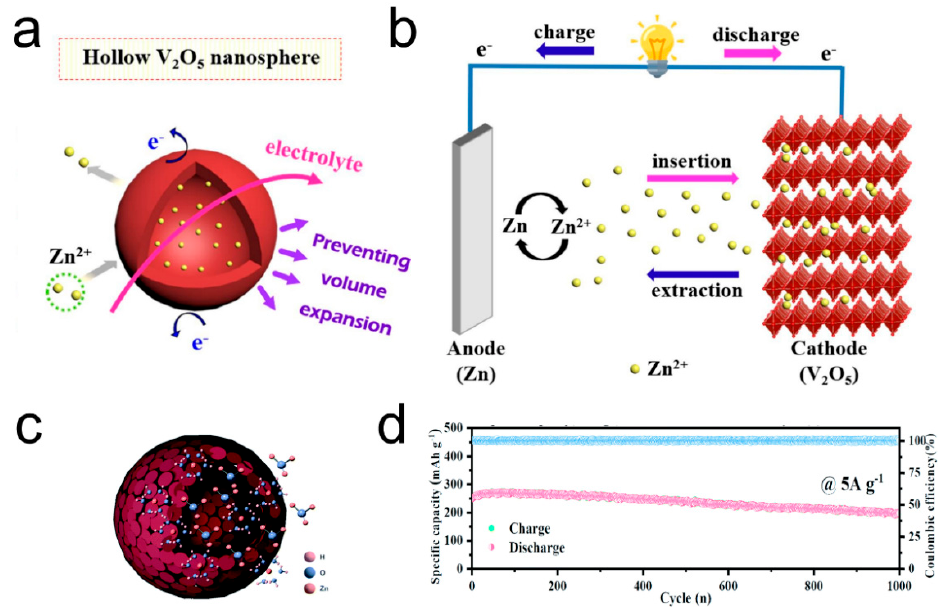
Figure 5. ( a , b ) The fabrication of Hollow V 2 O 5 nanospheres and their electrochemical properties Reproduced with permission from reference [60]. ( c , d ) Schematic of the as-prepared V 2 O 5 − YS microspheres and their electrochemical properties Reproduced with permission from reference [61].